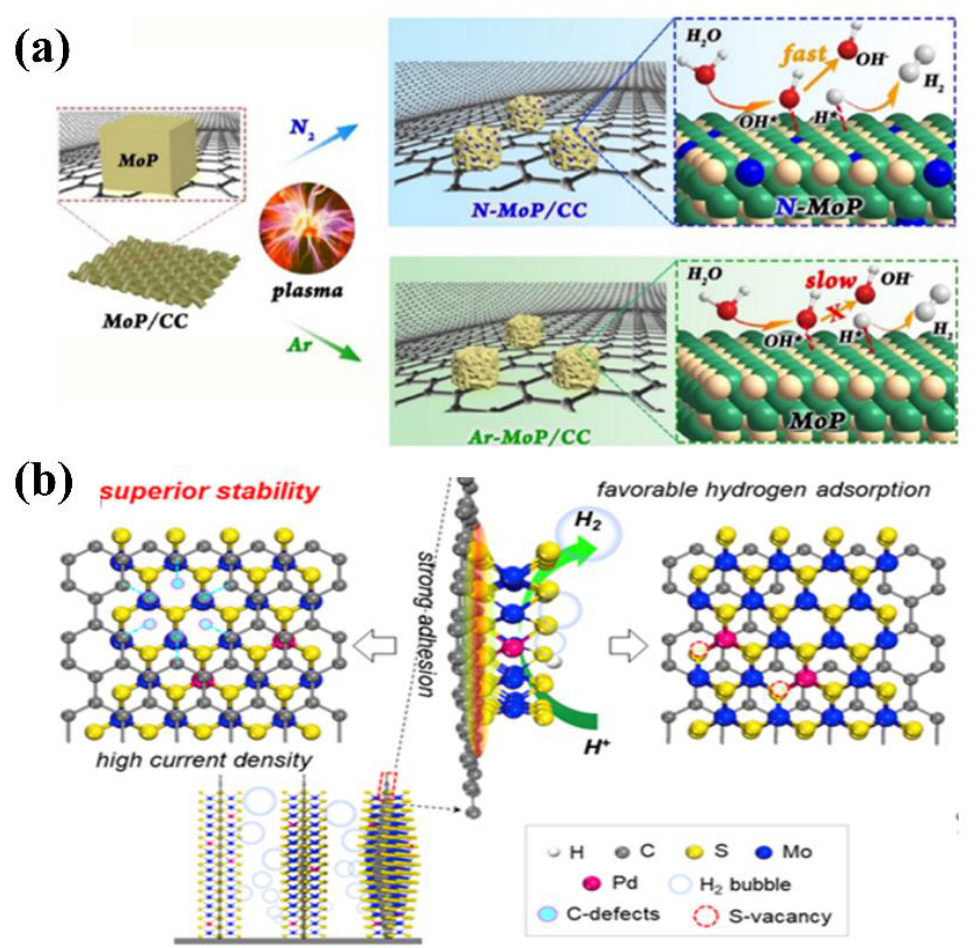
Figure 1. ( a ) schematic illustration for fabricating N-MoP / CC. Copyright 2020 Elsevier. ( b ) schematic illustration of hydrogen evolution catalyzed by palladium-doped MoS 2 anchored on vertical grapheme. Copyright 2020